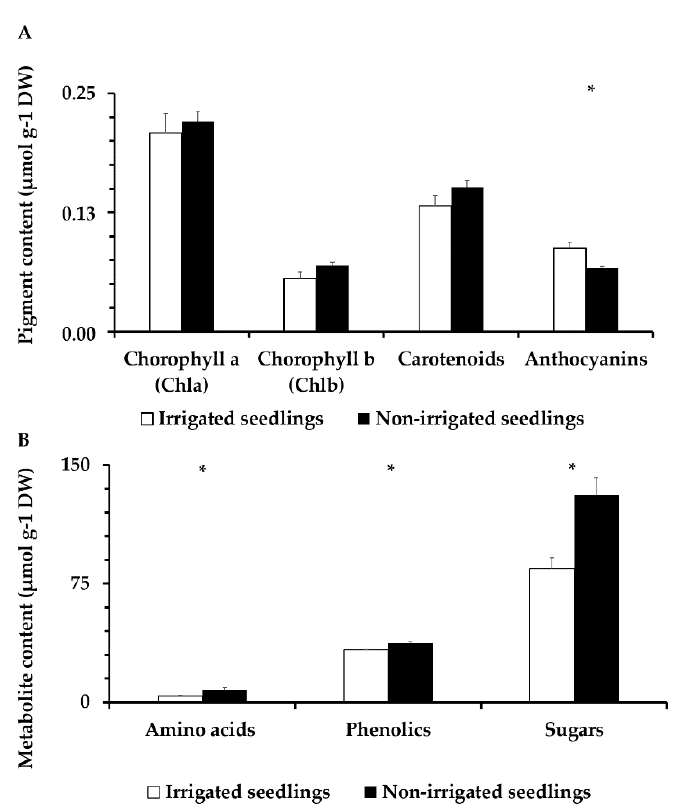
Figure 5. Photosynthesis pigment (chlorophyll (a and b) and carotenoids) and anthocyanins ( A ) and metabolite (phenolics, sugars, amino acids) ( B ) contents in leaves of the Q. ilex Se population. Values are mean ± SE of three biological replicates at day 25. Asterisk indicates significant differences between irrigated and non-irrigated seedlings (* p < 0.05).